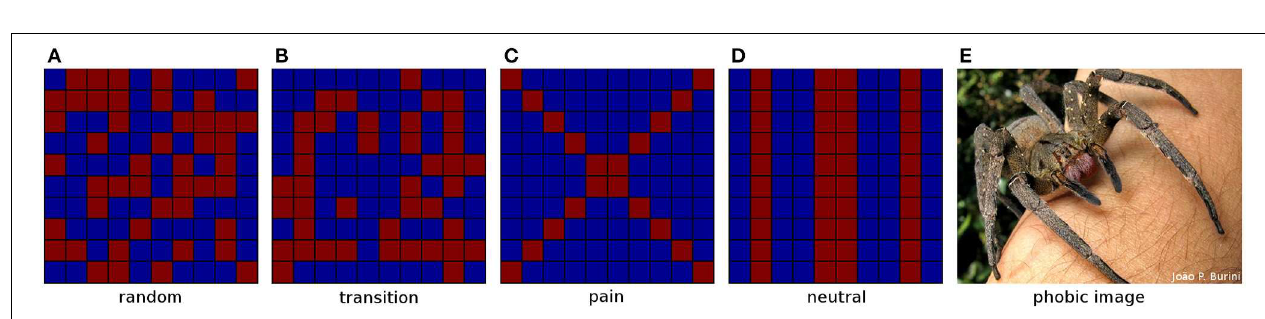
FIGURE A3 | Protocol for fear regulation. Starting from (A) , random transitions of pixels occur as in (B) until an icon such as (C) or (D) fully forms or a phobic image such as (E) appears. Pain icons are pre-conditioned, but